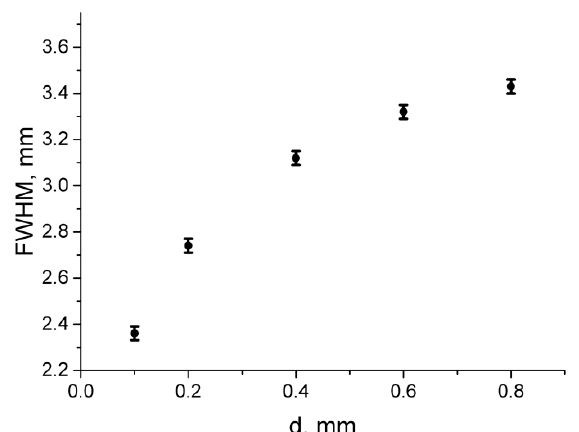
Figure 8. Dependence of the fluorescence profile FWHM on the BPD tube diameter. The tube center is located 1.1 mm under the surface.